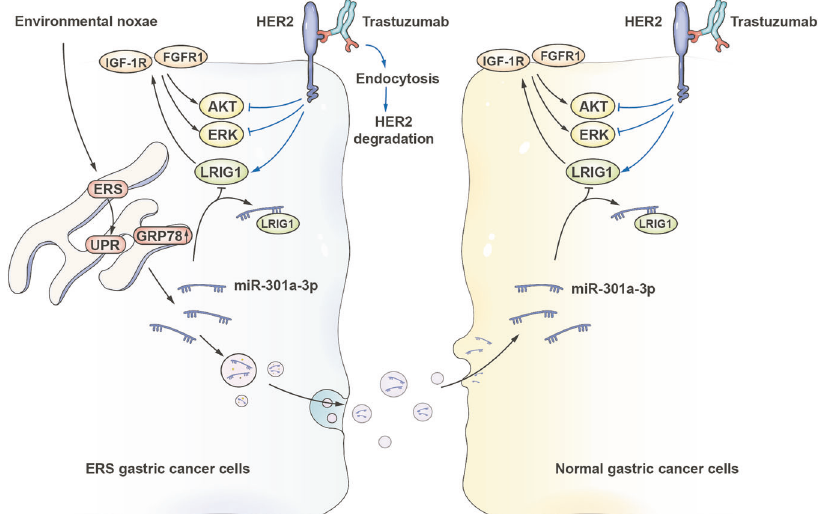
Fig. 8 A schematic diagram of miR-301a-3p based signalling circuit of trastuzumab resistance in HER2-positive GC. miR-301a-3p promoted trastuzumab resistance in ER stressed GC cells by downregulating the expression of LRIG1, resulting in an increase in the expression of IGF-1R and FGFR1, and the activation of ERK and AKT signalling pathway. Moreover, miR-301a-3p could be carried by exosomes and secreted by ER stressed GC cells, transmitting trastuzumab resistance to unstressed recipient